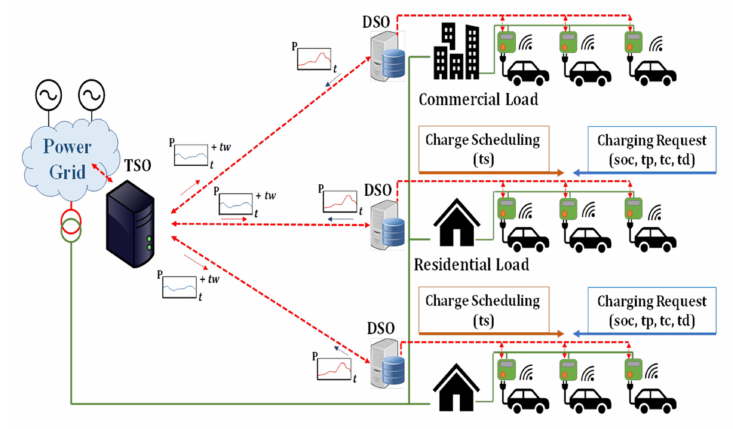
Figure 1. Charge scheduling